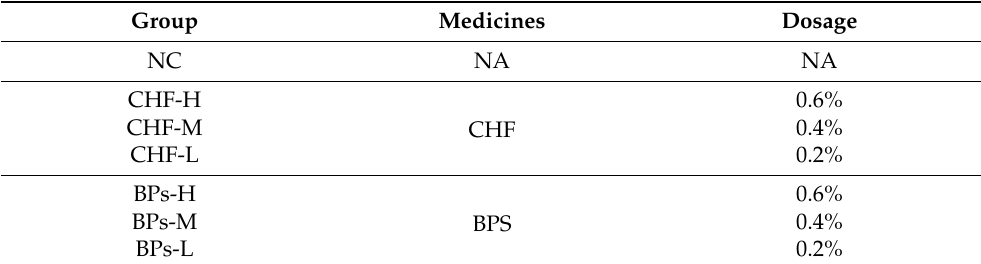
Table 3. Dosage of medicines. Group Medicines